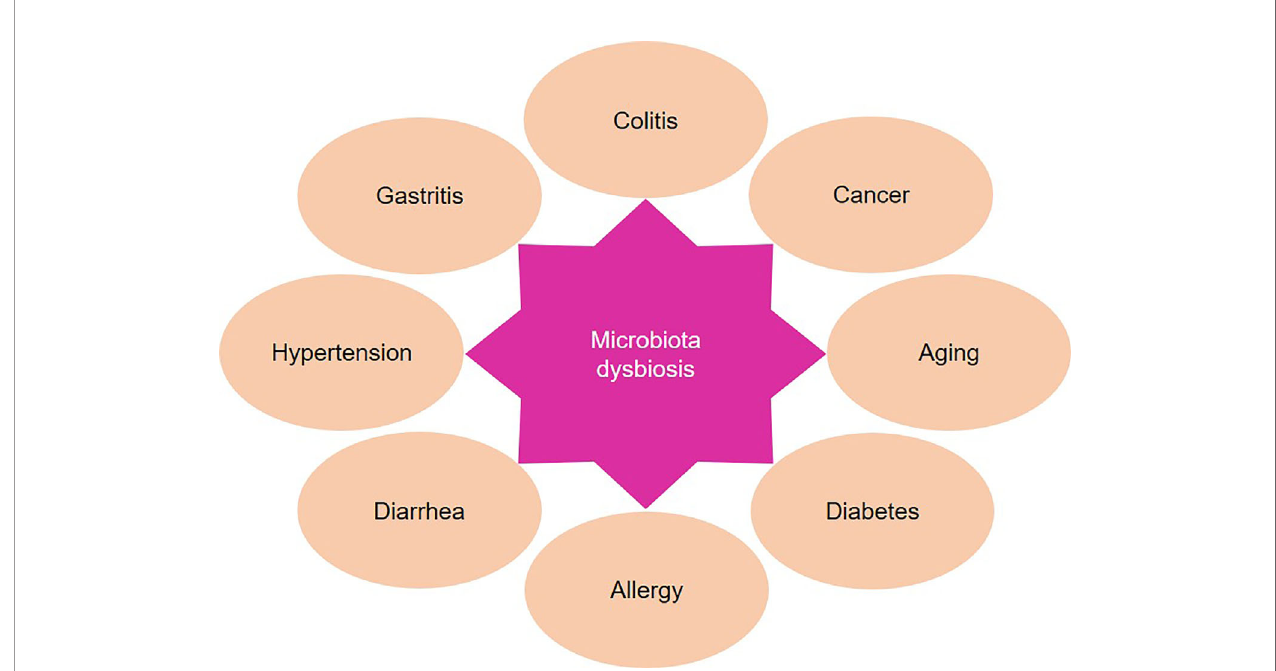
FIGURE 1 | Microbiota dysbiosis is involved in the development of multiple diseases. The intestinal fl ora affects immune, metabolism and other functions of the host. Microbiota dysbiosis leads to a series of diseases, such as diabetes and